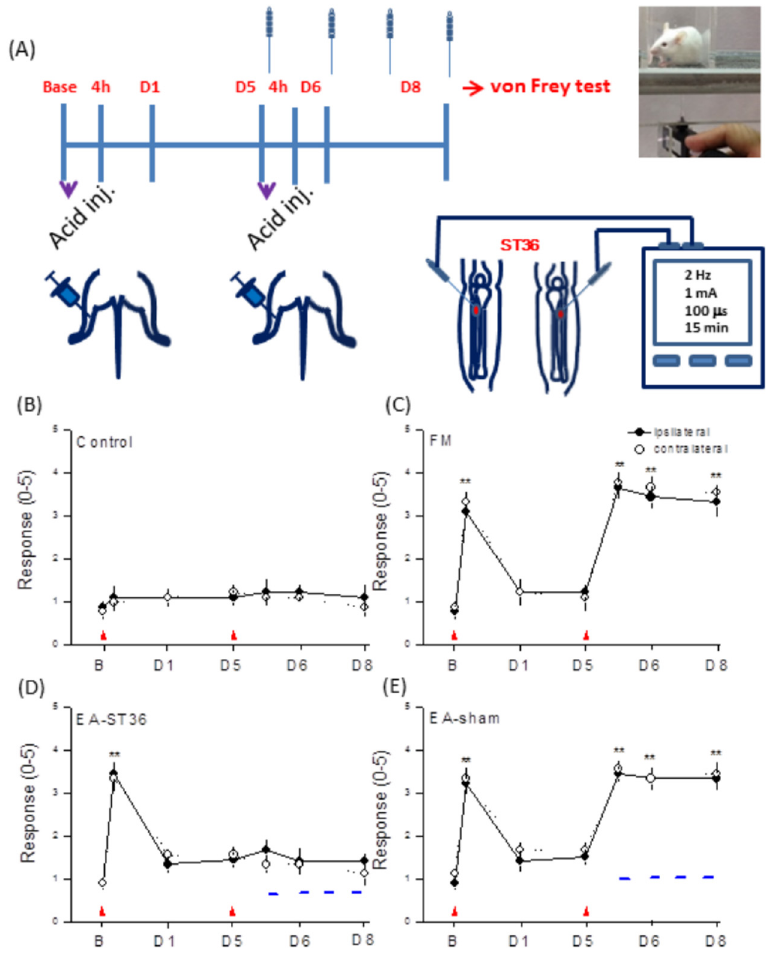
Fig 1. Electroacupuncture (EA) attenuated mechanical hyperalgesia induced by repeated intramuscular acid saline injection (fibromyalgia model, FM) as measured by von Frey filaments. (A) Mechanical responses of saline-injected control mice. (B) Mechanical responses of FM group mice. (C) Mechanical responses of FM mice pretreated with EA (FM + EA group). (D) Mechanical responses of FM mice pretreated by sham EA. Mice were tested before injection (baseline, B), 4 hours after injection, day 1 (D1), day 5 (D5), day 6 (D6), and day 8 (D8). Red arrowheads indicate acid injection; Blue dashes indicate EA. ** p < 0.01 compared to baseline (n = 9 mice per